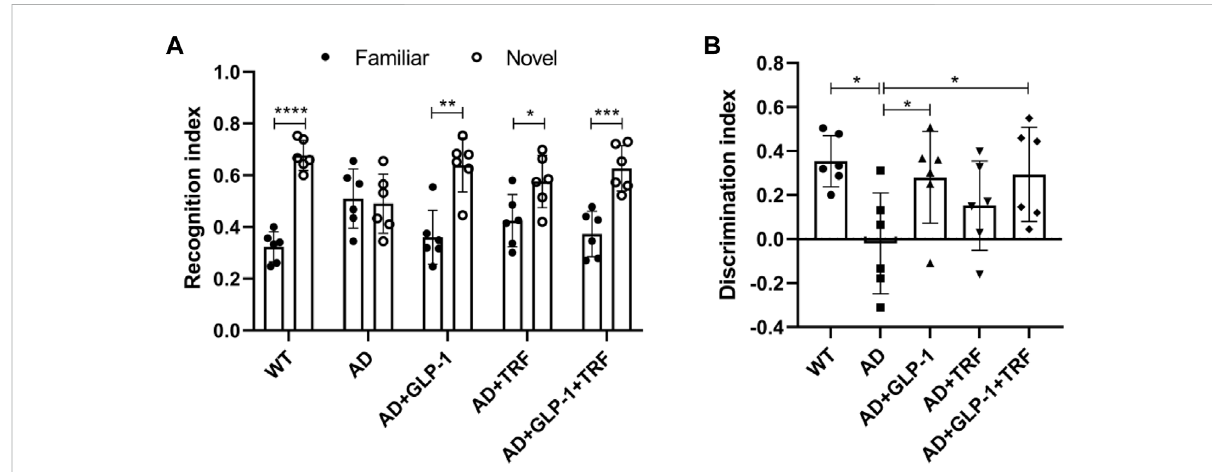
FIGURE 6 Novel object recognition task reveals improvement of GLP-1 and TRF on long-term memory and attention de fi cits in AD mice. (A) Recognition index was de fi ned as the time to explore a familiar or new object/total time to explore both objects. n = 6, Two-tailed t -test, * p < 0.05, ** p < 0.01, *** p < 0.001, **** p < 0.0001. (B) Discrimination index is calculated as the difference between the time spent exploring a new object and a familiar object/the total time spent exploring both objects. n = 6, One-Way ANOVA, * p < 0.05 vs. AD